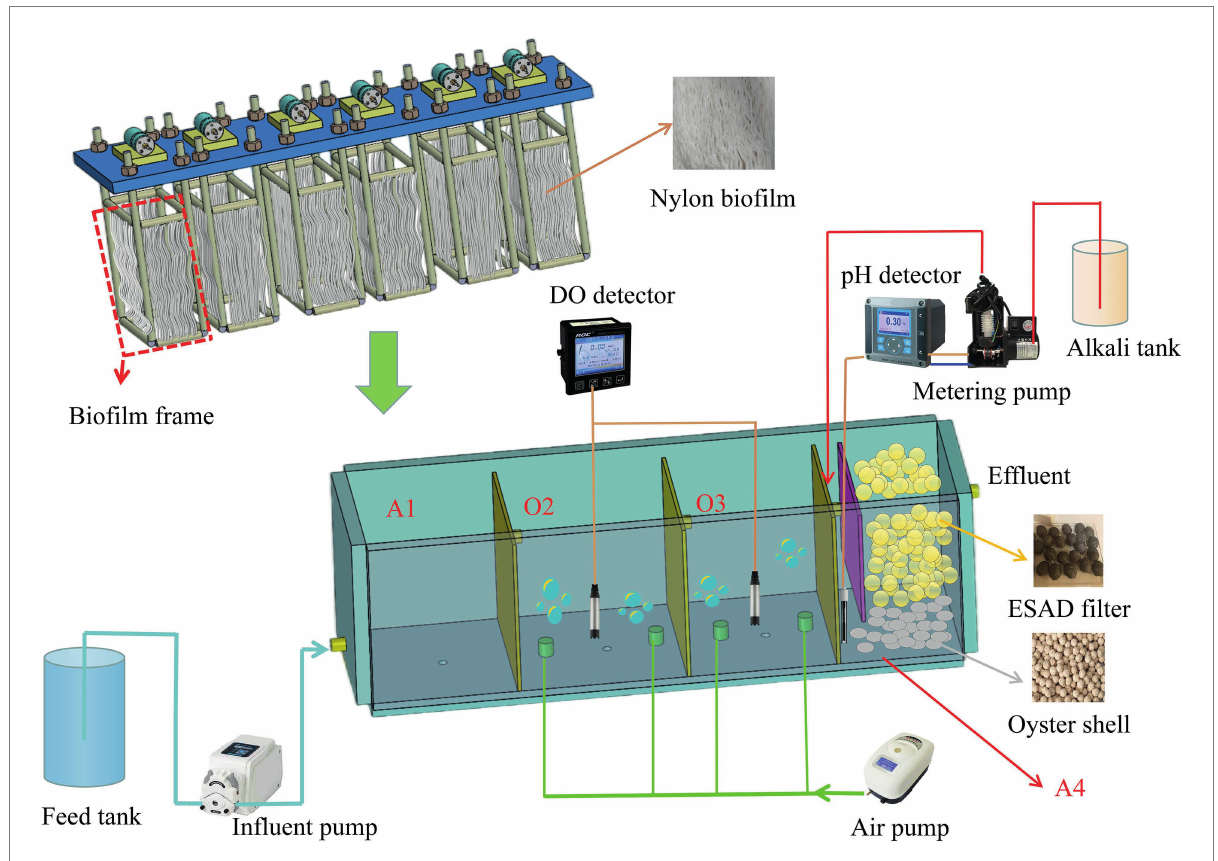
FIGURE 1 The schematic diagram of the reactor.